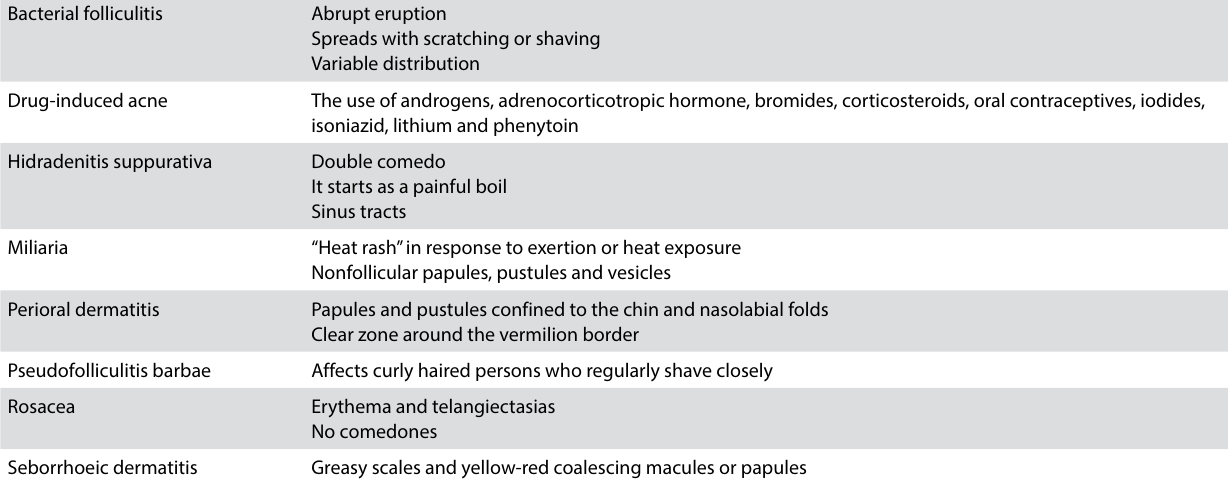
Table 1: The differential diagnosis of acne 3